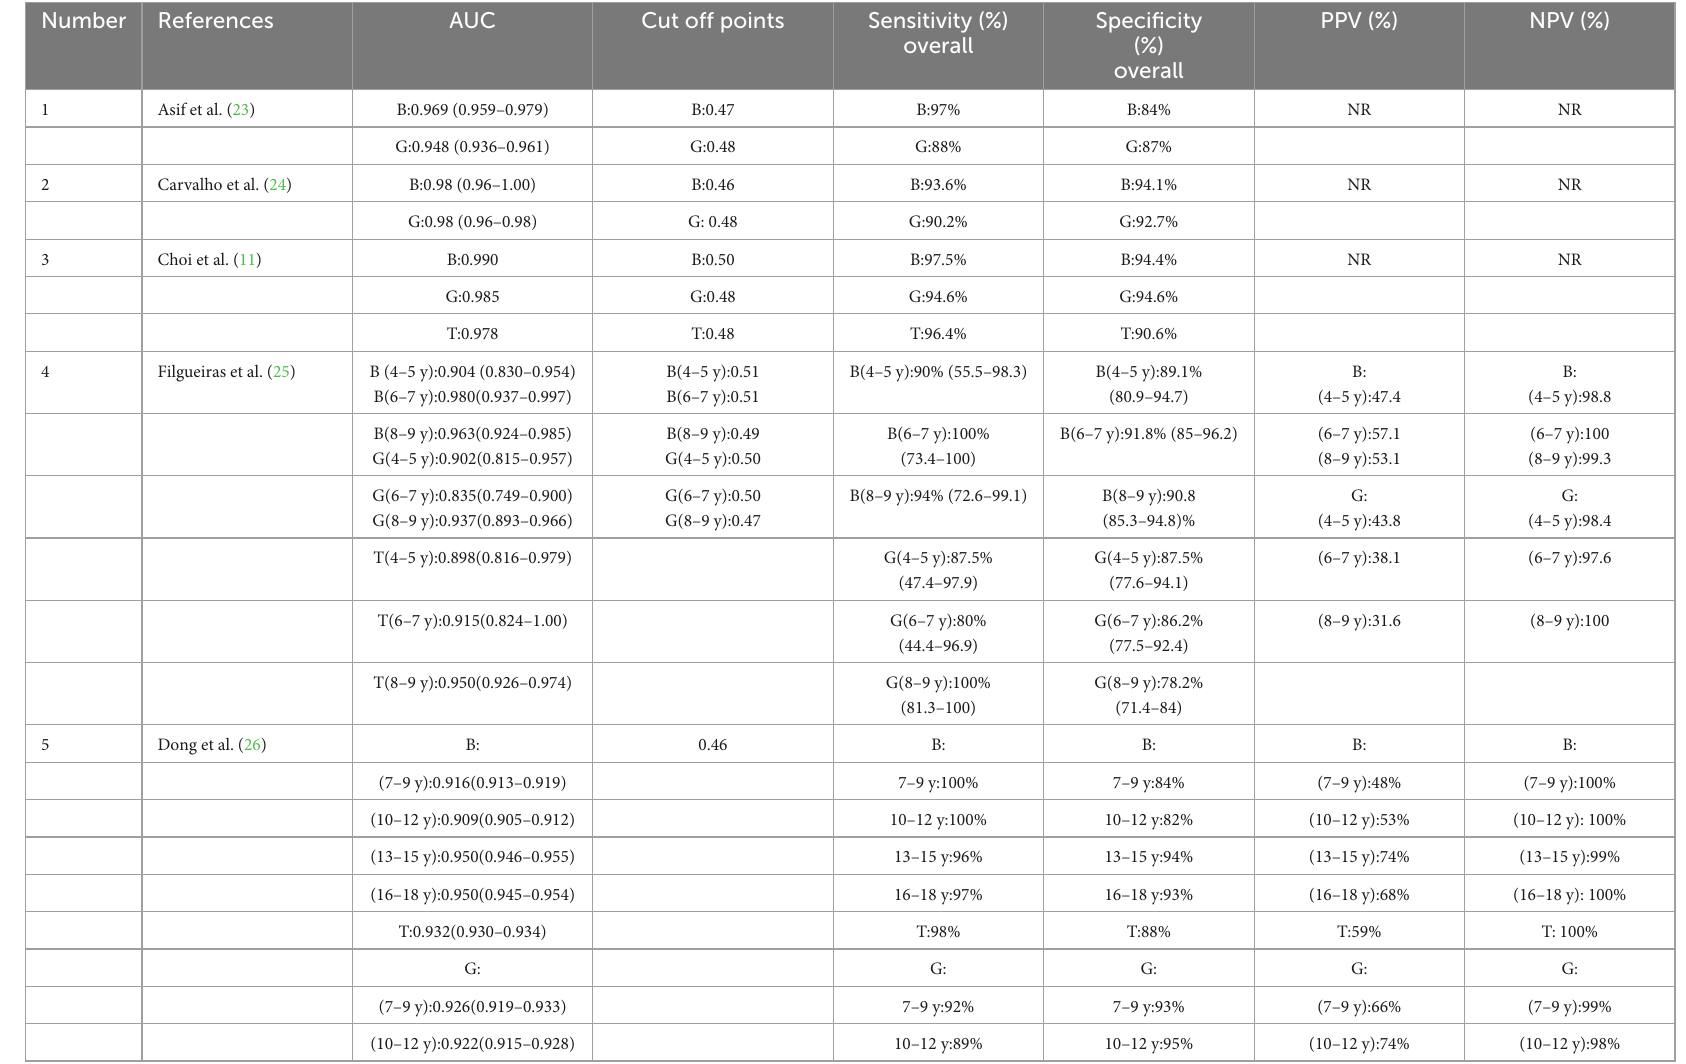
TABLE 2 The list of included studies with reported cut-offs and ROC curve analysis data for predicting abdominal